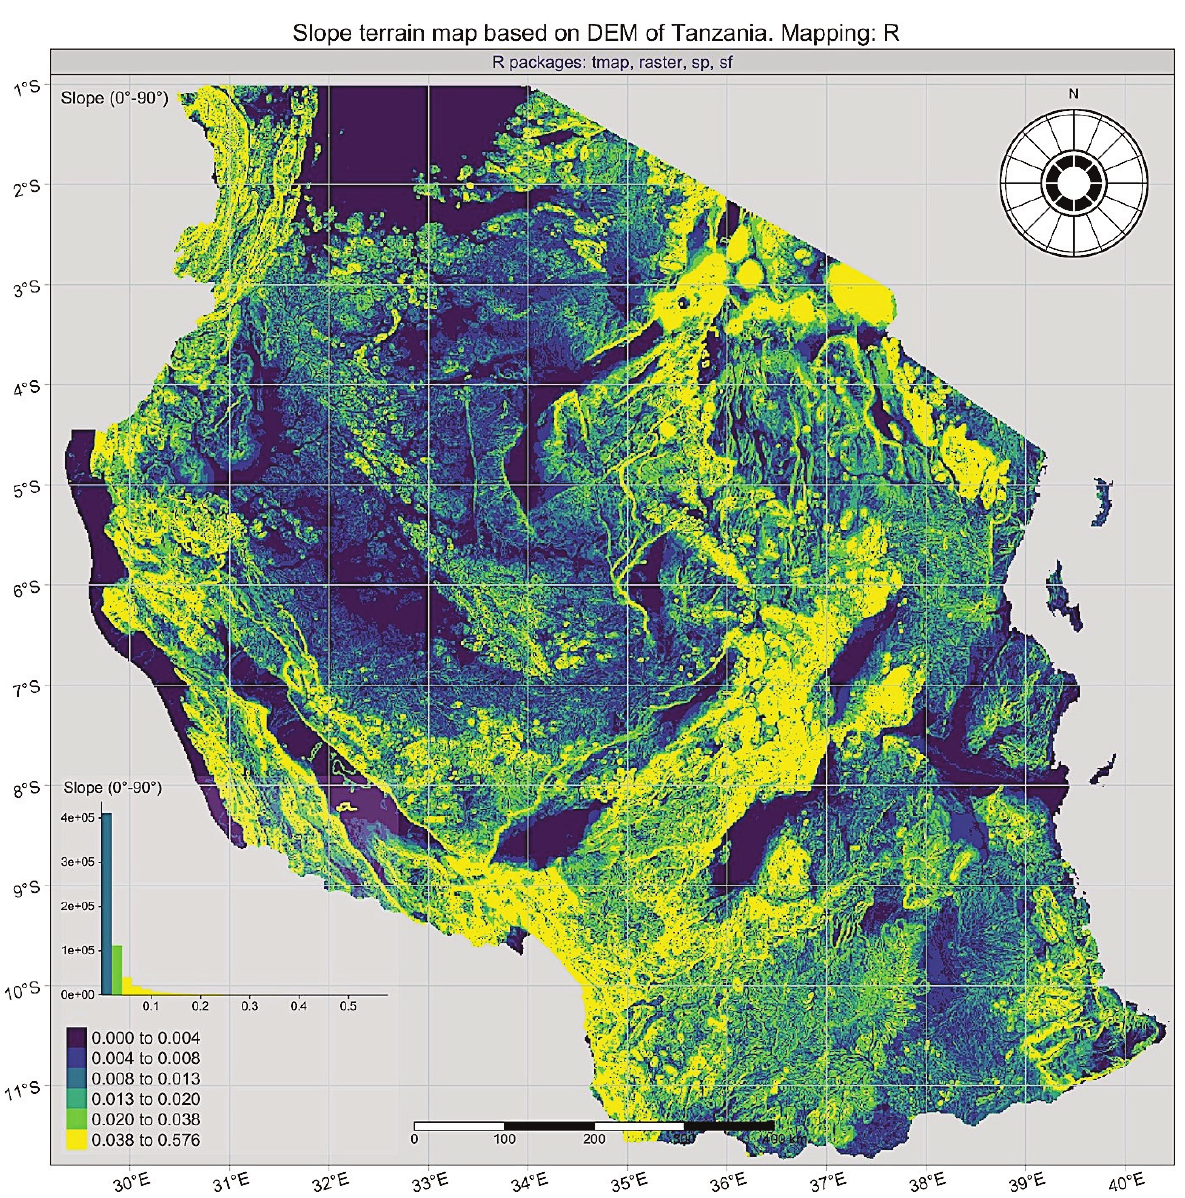
Fig. 9. Slope terrain visualization based on DEM of Tanzania. Mapping by R using packages ‘tmap’, ‘raster’, ‘sp’, ‘sf’. Map source: elaborated by the